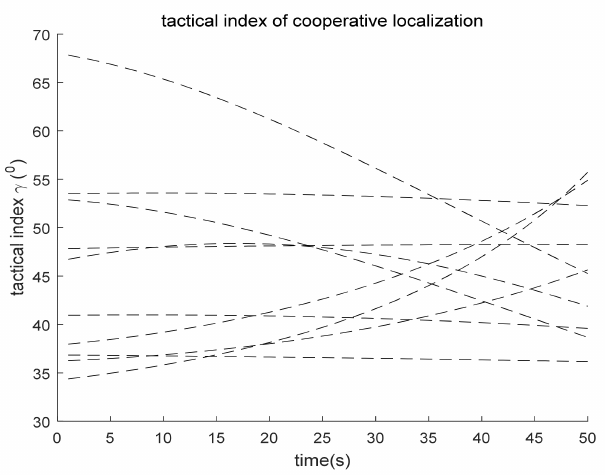
Figure 15. Intersection angle γ between direction localization platform and each point of the target track.